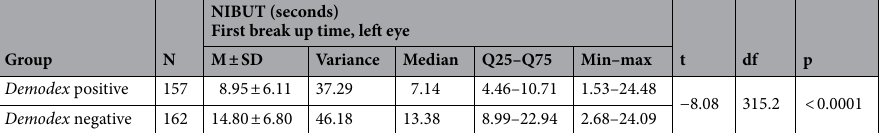
t df pM ± SD Variance Median Q25–Q75